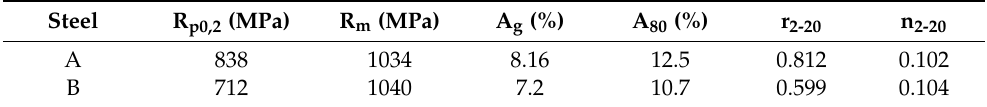
Table 3. Mechanical properties of steels A and B.